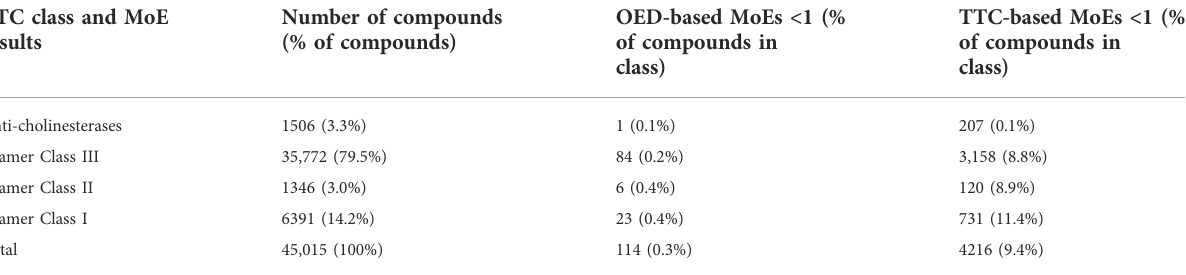
TABLE 3 Summary of the large dataset of CERAPP chemicals that are classi fi ed into four TTC categories based on Cramer decision tree results along with the number of chemicals with estimated TTC-based margins of exposure (MoE) of less than one.